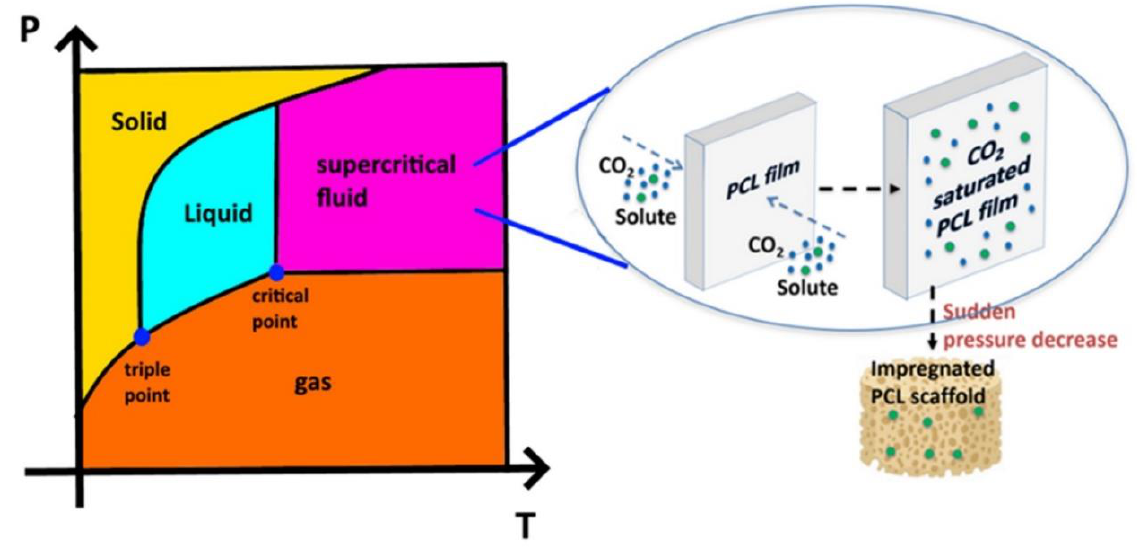
Figure 1. Pressure-temperature phase diagram and scheme of the simultaneous supercritical carbon dioxide (scCO 2 )-assisted foaming and impregnation of polymers.